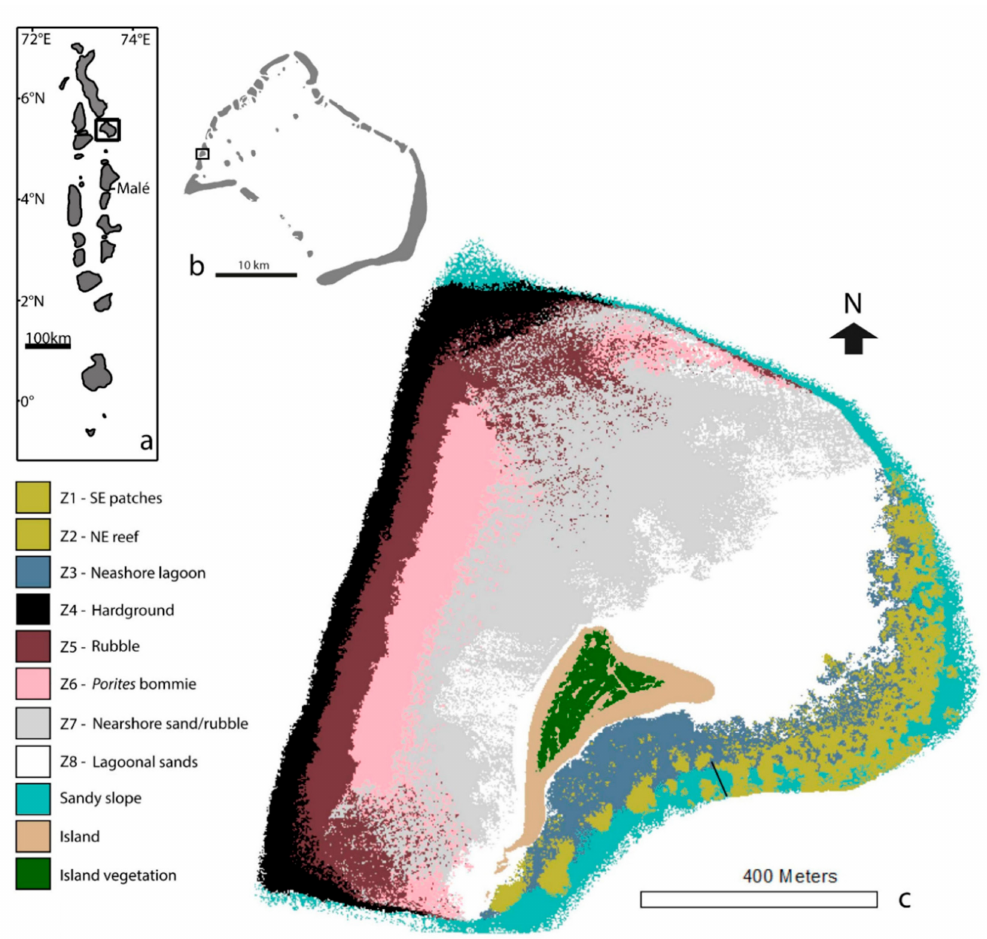
Figure 1. ( a ) Position of Lhaviyani Atoll in the Maldives. ( b ) Position of Vavvaru on Lhaviyani Atoll. ( c ) Habitat map of Vavvaru produced from Quickbird imagery of western Lhaviyani Atoll taken on 9 July 2008 (provided by DigitalGlobe Foundation; http: // www.digitalglobefoundation.org / ) and ground validated points. See Perry et al. (2017) [28] for original publication and position of ground points. Note that the southeast (SE) patches (Z1) and northeast (NE) reef (Z2) could not be di ff erentiated during analysis of satellite data and are presented as the same color here. However, the black line marks the division of NE reef and the SE patches, which were treated as separate habitats (based on in-situ observations and geo-ecological data collection) in the estimates of bioerosion rate and grazing pressure in the present